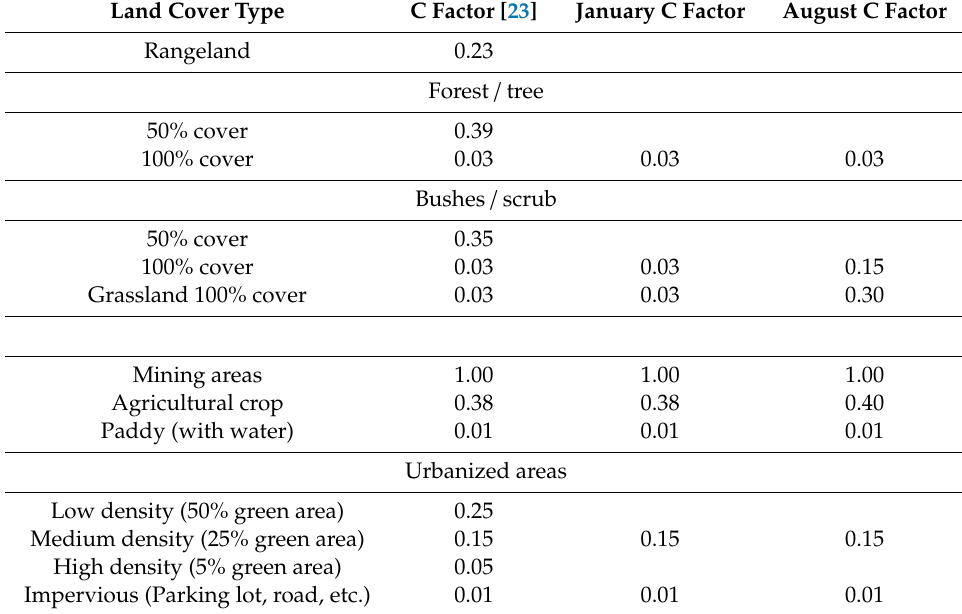
Table 2. C factor for selected land cover classes in Malaysia [23:41 ff ] and assigned values used in this